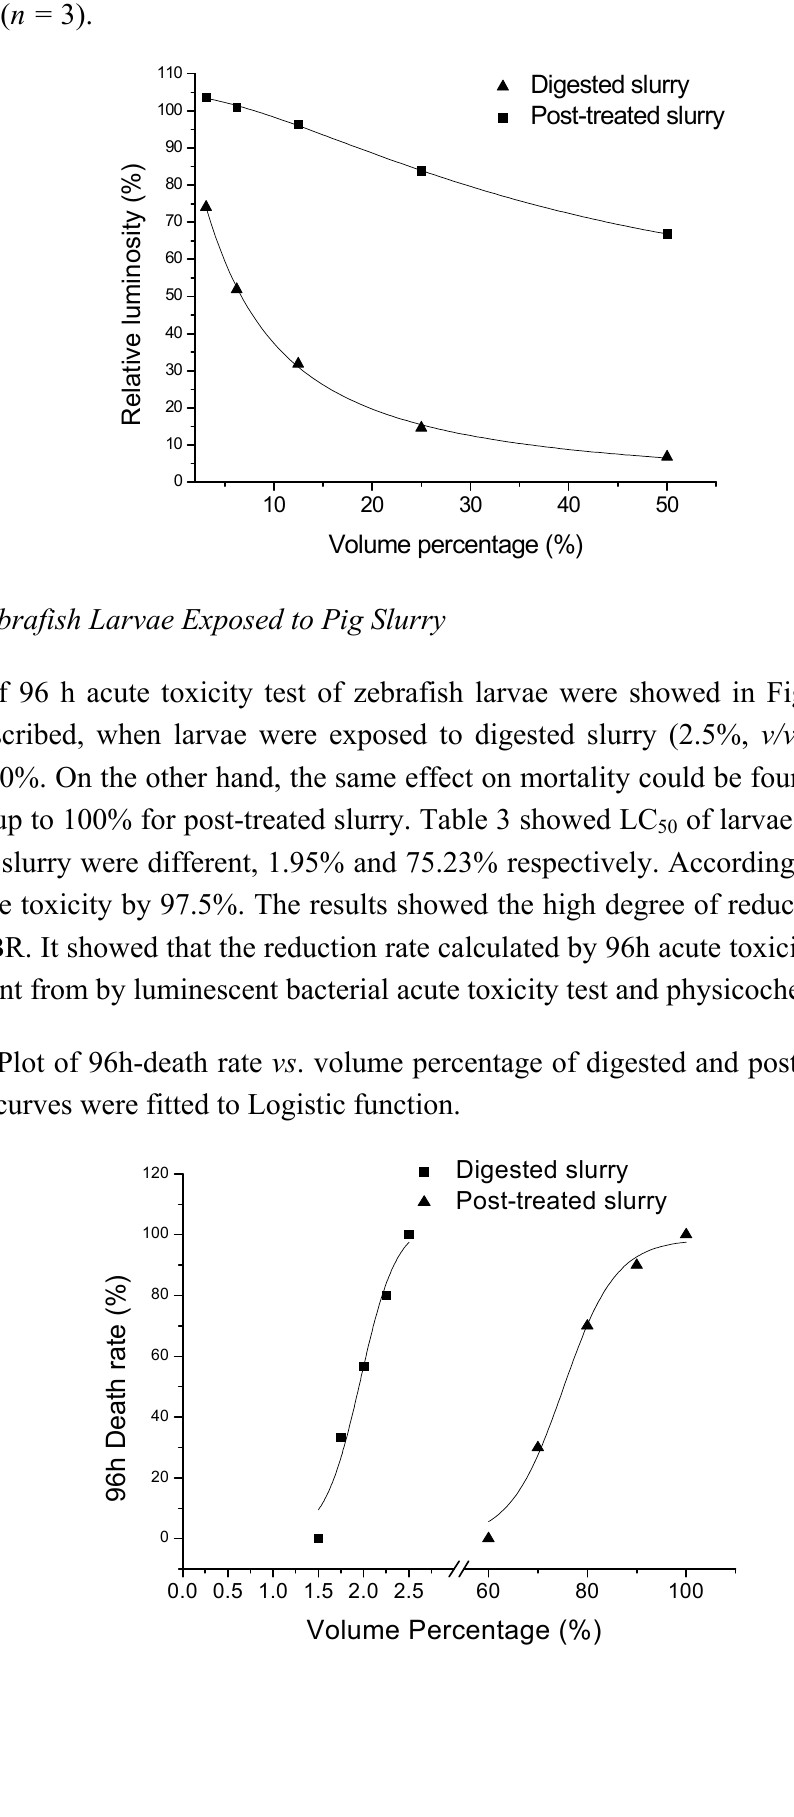
Figure 1. Plot of relative luminosity vs . volume percentage of digested and post-treated slurry where the curves were fitted to Logistic function. Results are means standard deviations ( n = 3).